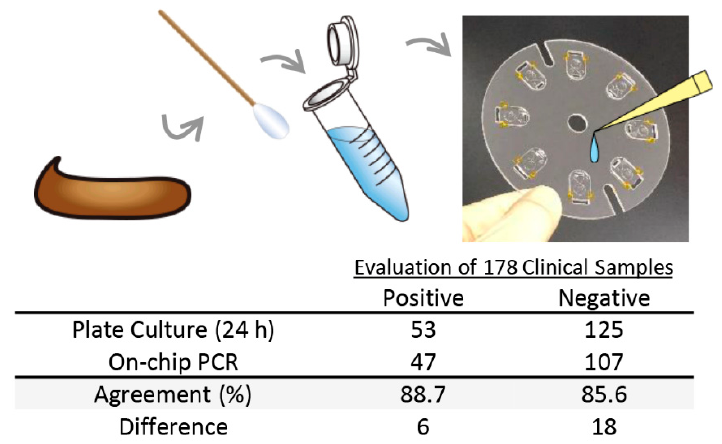
Figure 5. Comparison of plate culture test and on-chip PCR test for detecting Carbapenem-re- sistant Enterobacteriaceae (CRE) from 178 stool samples. Enterobacteriaceae (CRE) from 178 stool